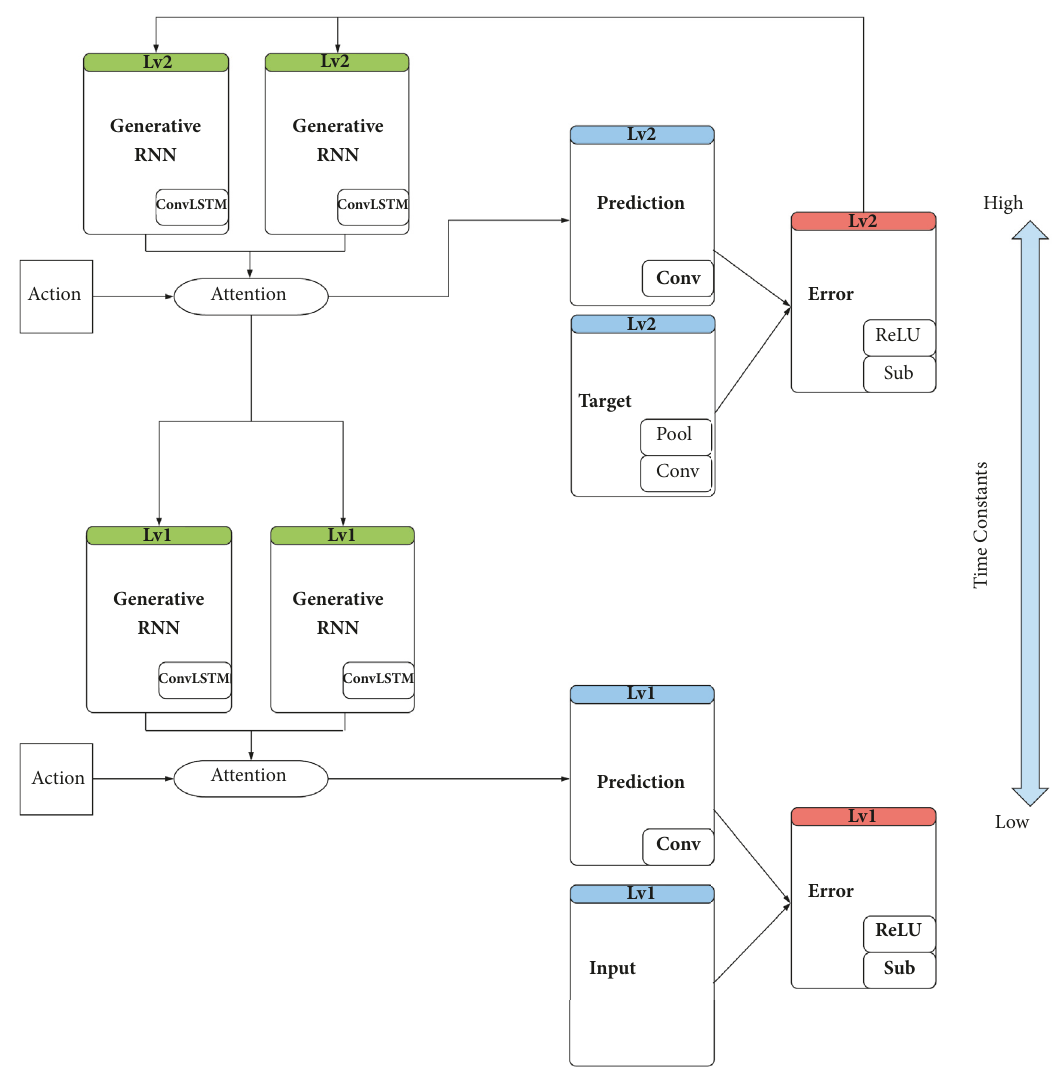
Figure 1: A 2-layer MT-AFA-PredNet. A 2-layer MT-AFA-PredNet Example: the green (generative) units calculate (Eq. (9)) for prediction and further combine proportionally by the attention unit (Eq. (10)). The red units calculate the error (Eq. (8)). The error is obtained from blue units (Eq. (7) (Prediction) and Eq. (6) (Target)). Moreover, the time constant changes on different